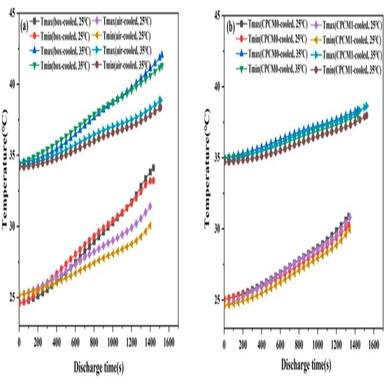
The variation of battery temperature at different ambient temperature at discharge rate of 1C: (a) temperature rise under box and air cooled (b) temperature rise under CPCM0 and CPCM1 cooled.